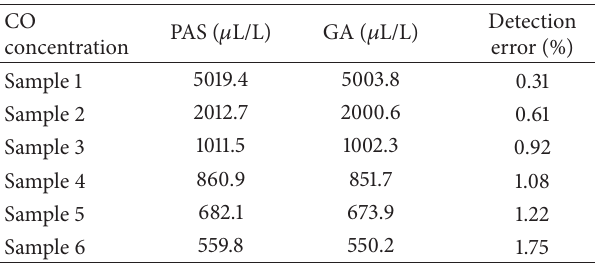
Table 1: Measurement results detected by PAS and GA. CO PAS ( 𝜇 L/L) GA ( 𝜇 L/L) concentration